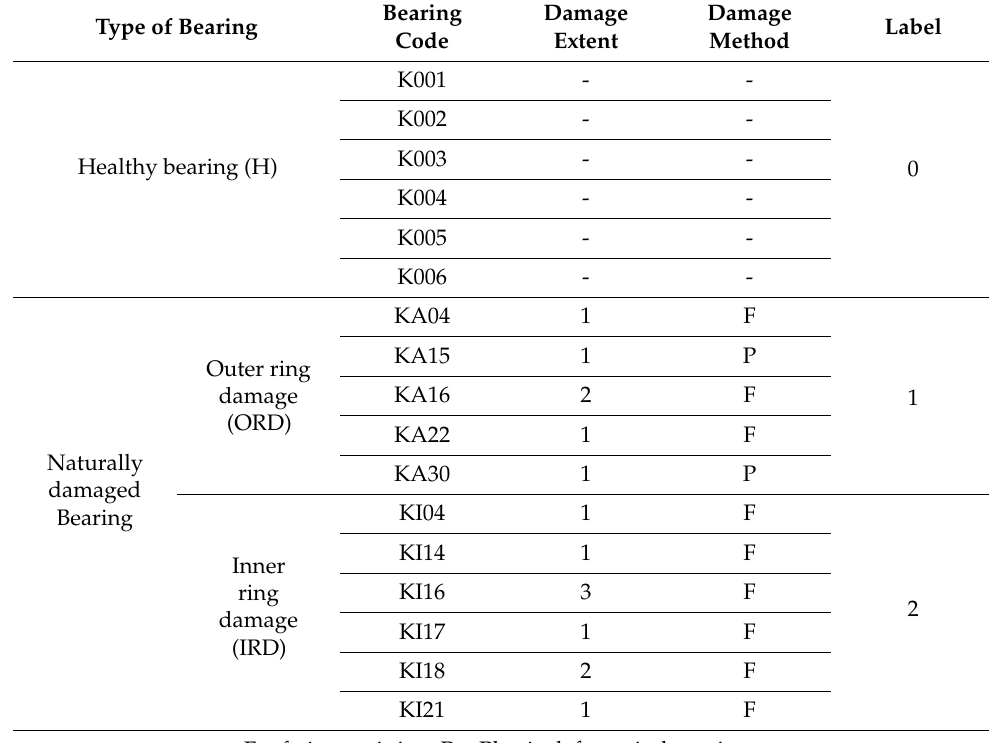
Table 2. Characterization of bearings considered in this